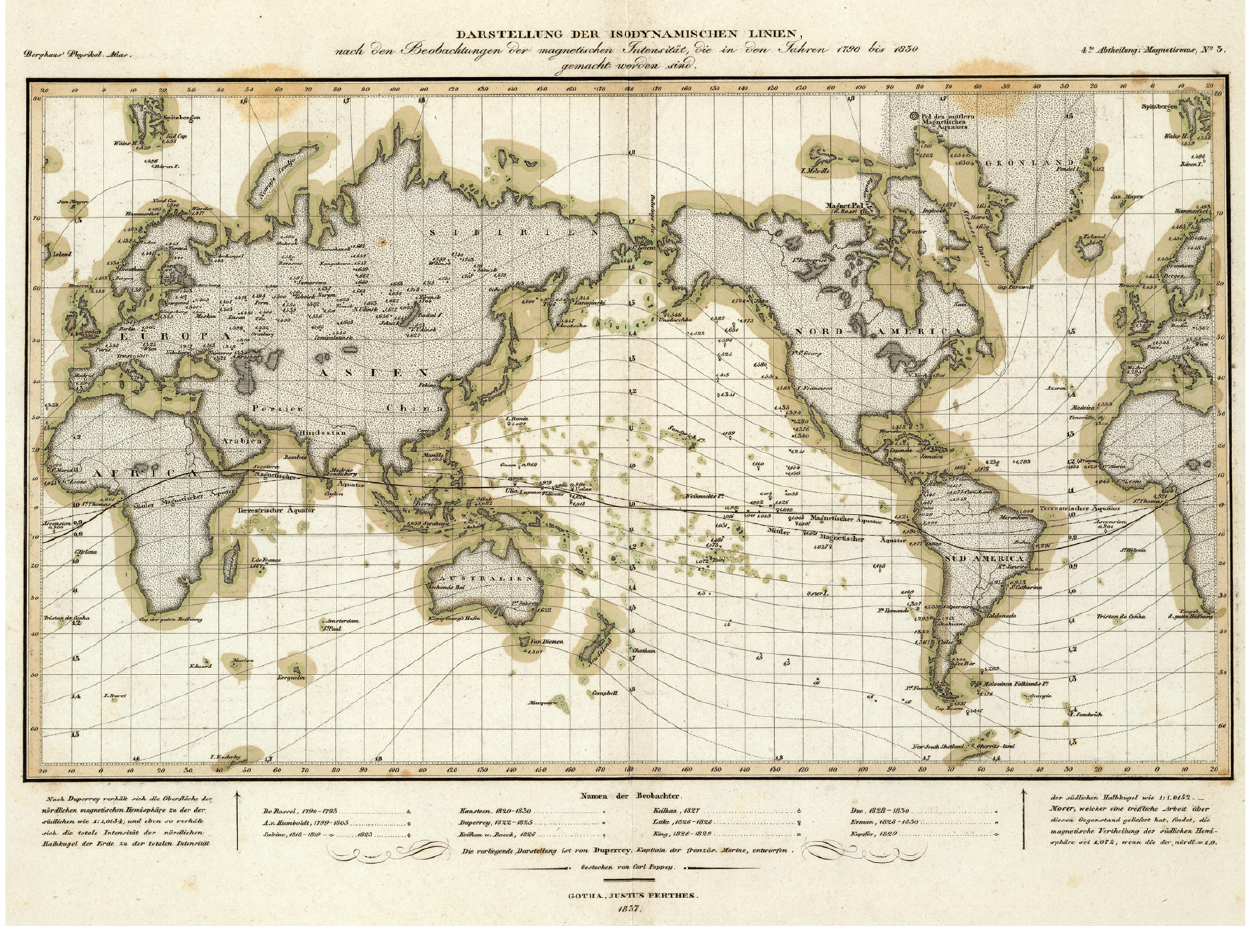
Figure 7. World map of isodynams of intensity measured in 1790–1830 published in Gotha in 1837. The values are given in relative “Humboldt units”, magnetic equator is marked with a bold line (Berghaus, 1837–1848) (David Rumsey Map Collection, www.davidrumsey. com, USA; Images copyright © 2000 by Cartography